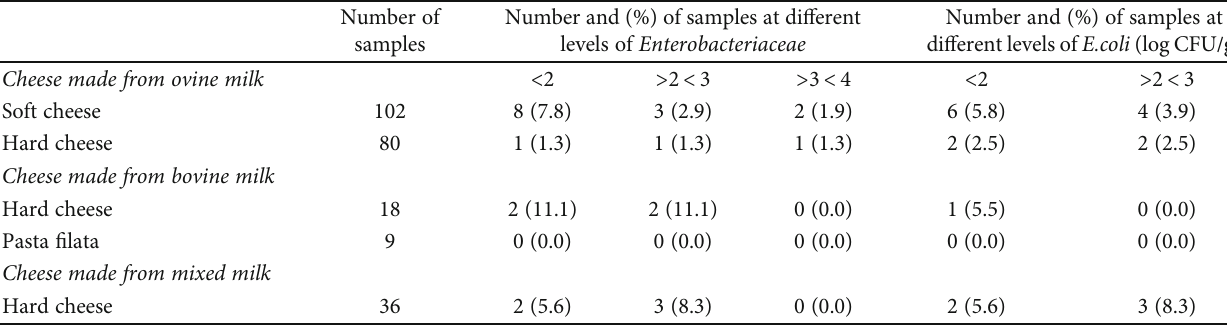
Table 2: Enterobacteriaceae and E. coli counts of cheese samples according to cheese categories. Number of Number and (%) of samples at di ff erent samples levels of